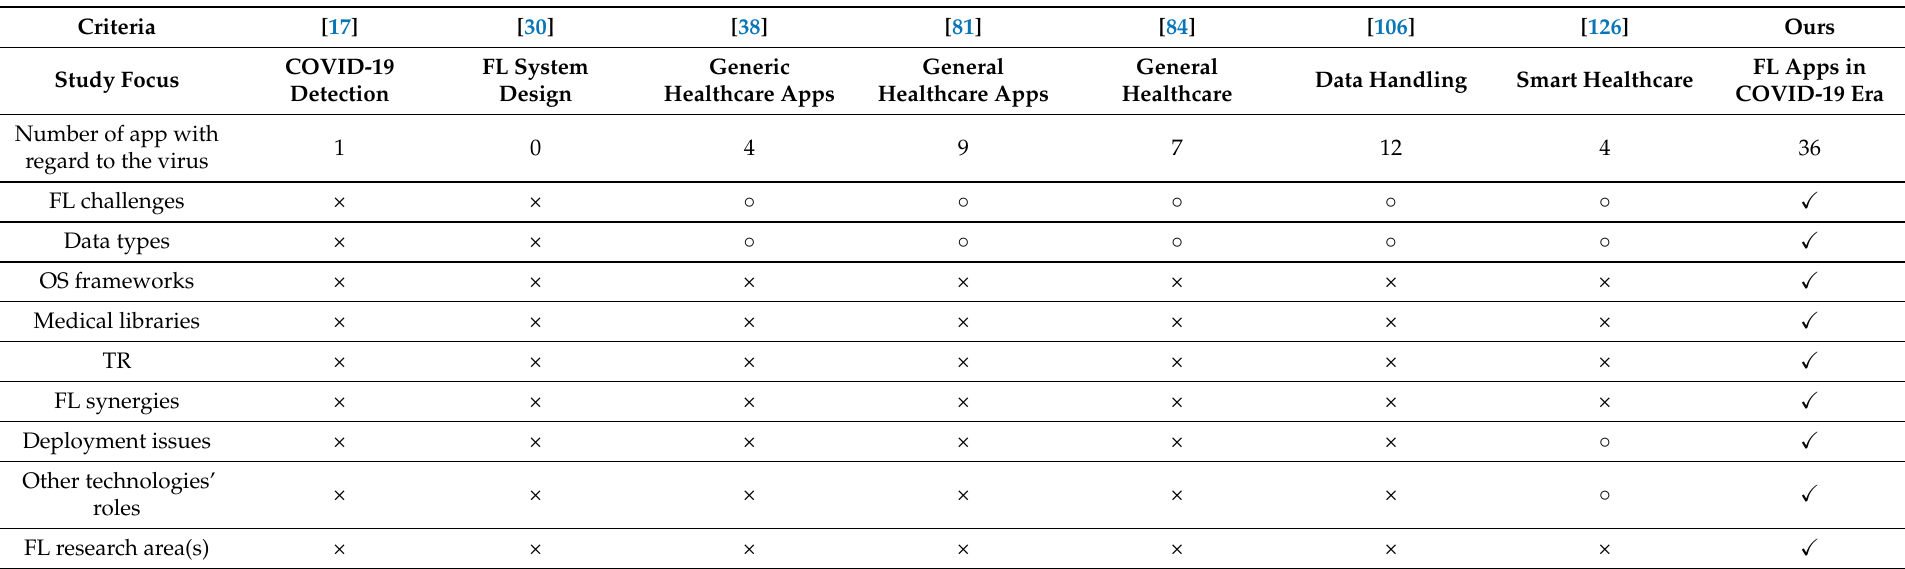
Table 6. Multi-criteria-based detailed comparison of the proposed work with existing SOTA